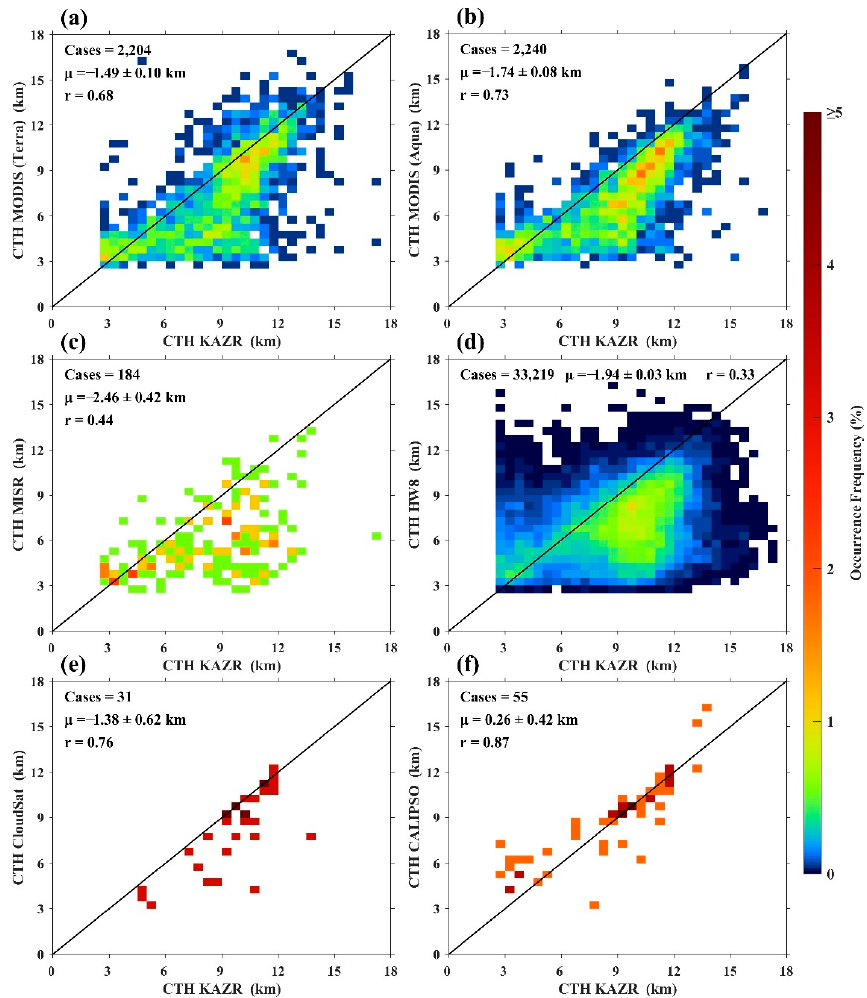
Figure 9. Same as Figure 5 but for overlapping